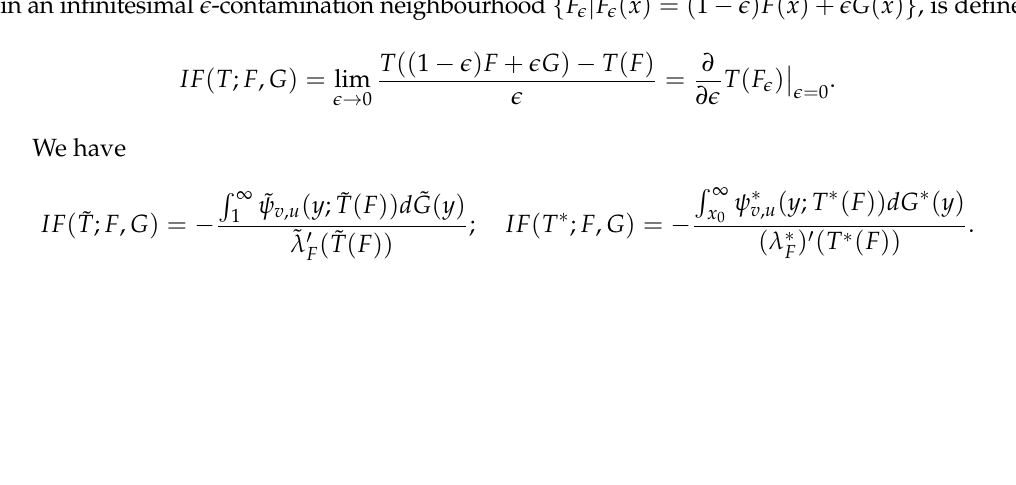
Figure 2. Relative asymptotic efficiency (AEFF) of ˜ T Here F W ( x ; α 0 ) is given by (1) with c 0 = 1, α 0 =